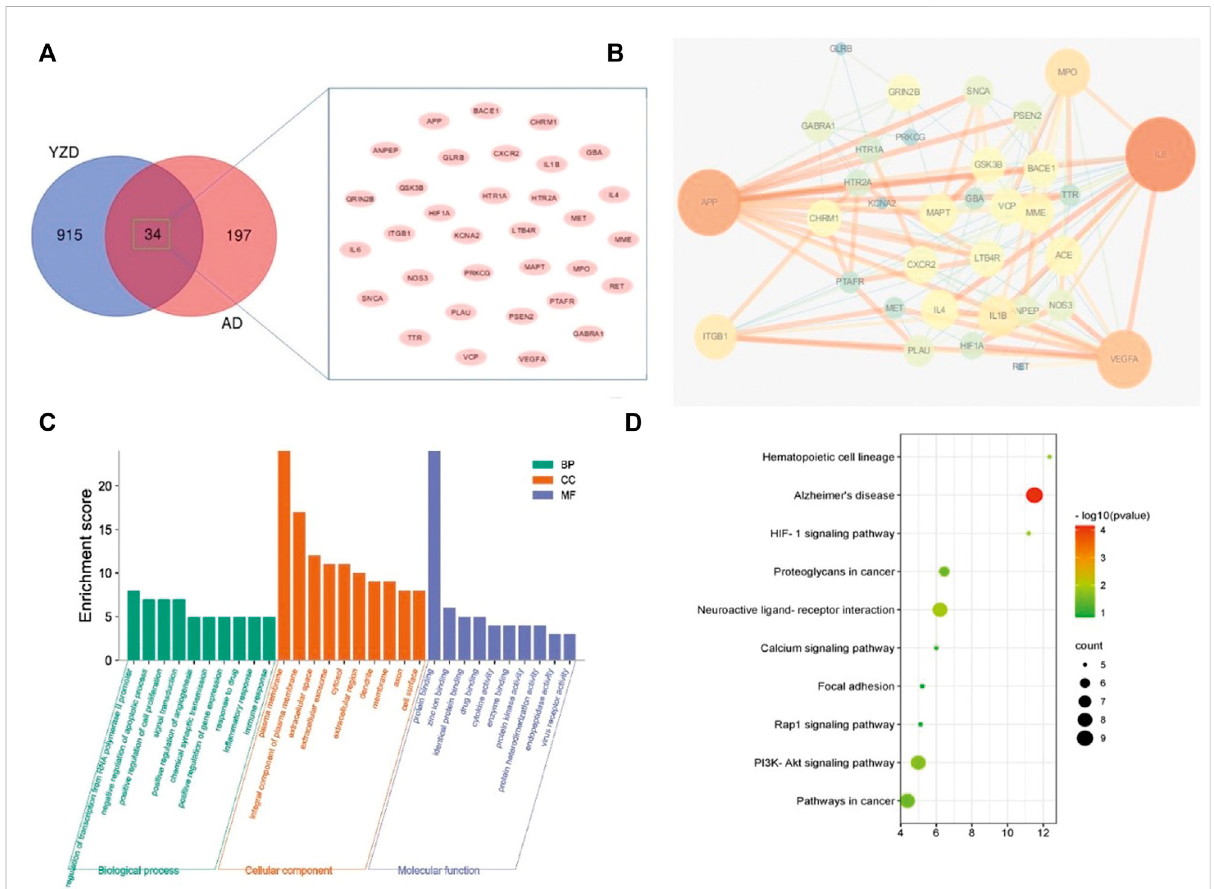
FIGURE 3 Analysis of proteins potentially affected by YZD treatment. (A) Venn diagram illustrating the overlap between proteins interacting with components of YZD and proteins know or predicted to be involved in the pathogenesis of AD. (B) PPI network of AD-related proteins that can interact with YZD components. (C) Analysis of the GO classi fi cation of the same set of proteins. (D) KEGG enrichment results of the interacting proteins represented as a bubble map. Red indicates greater, green a lesser enrichment of a given KEGG pathway, while the size of the bubbles corresponds to the number of proteins in each